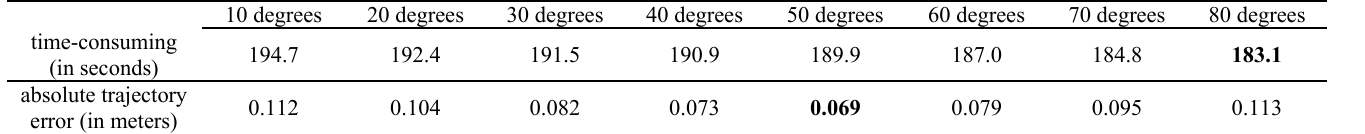
Table 1. The results of different